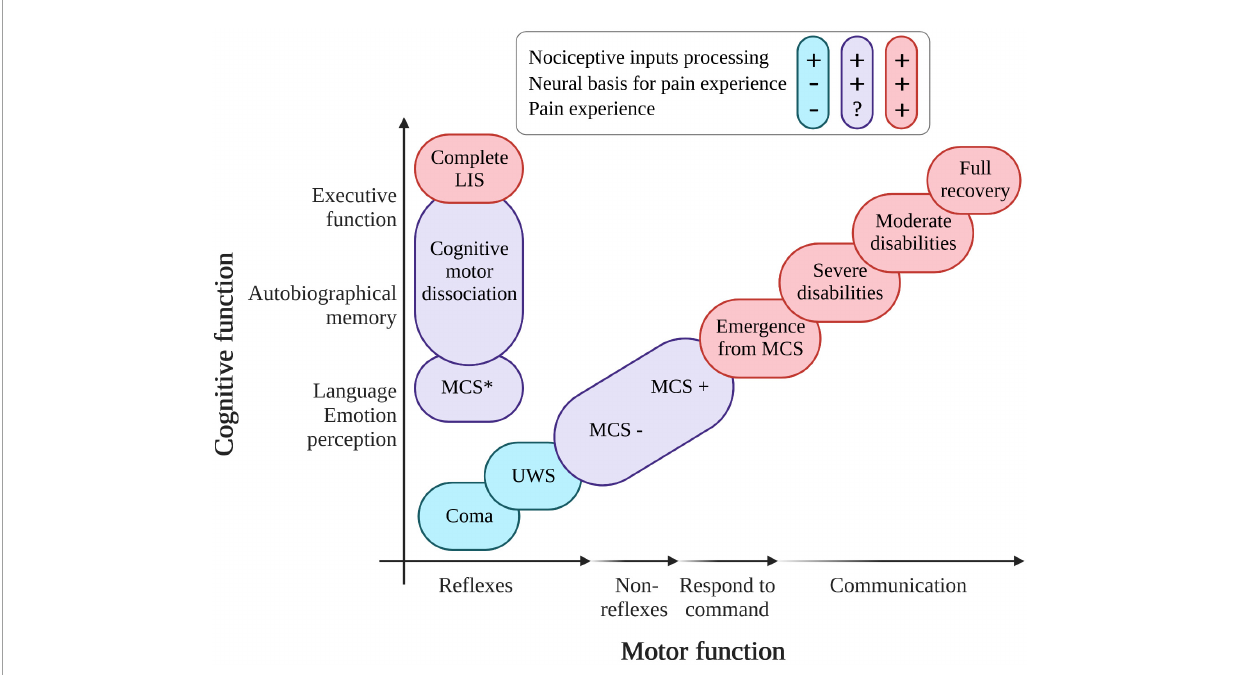
FIGURE1 Variation in diagnosis of patients with pathological states of consciousness according to the level of recovery of cognitive and motor functions. UWS, unresponsive wakefulness syndrome; MCS, minimally conscious state; LIS, locked-in syndrome; in red, patients able to process nociceptive inputs and able to experience pain; in blue, patients processing nociceptive inputs but without evidence of pain experience; in purple, patients able to process nociceptive inputs and having the (probable) neural basis for pain experience (created with BioRender.com, based on Thibaut et al. (2019) and recent empirical